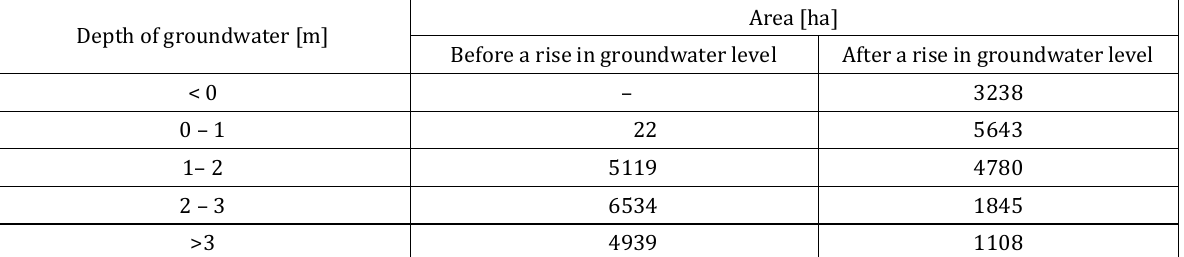
Table 1. The areas with different expected depths of groundwater Area [ha] Depth of groundwater [m] Before a rise in groundwater level After a rise in groundwater